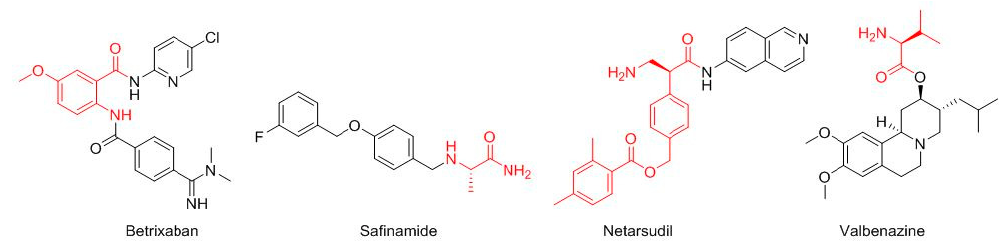
Figure 3. Structure of amino acid-based drugs. In red the amino acid.